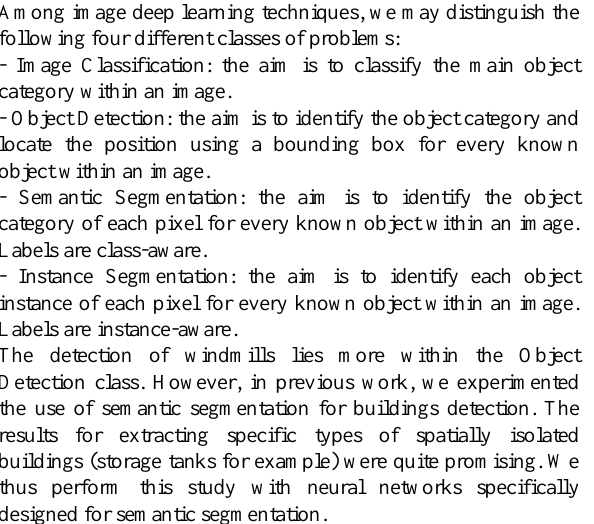
Figure 2 . U-Net architecture (Ronneberger et al.,